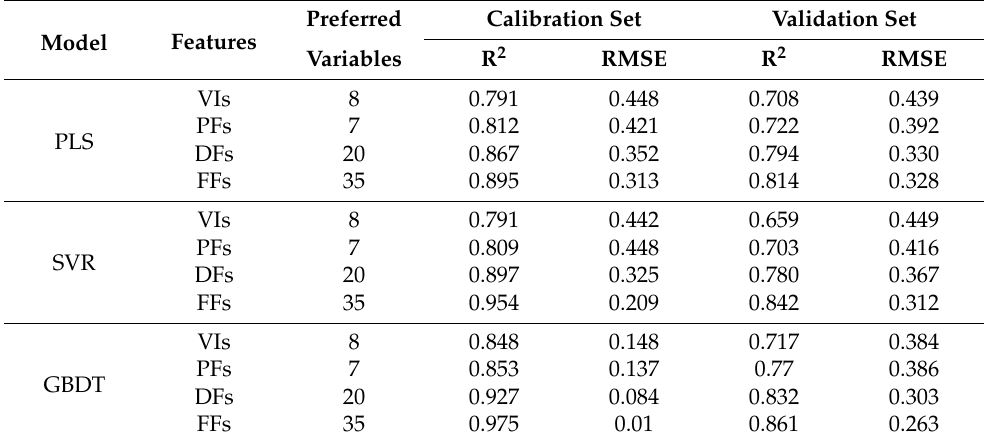
Table 4. Estimating model for wheat LNC from the selected input variables with three machine learning